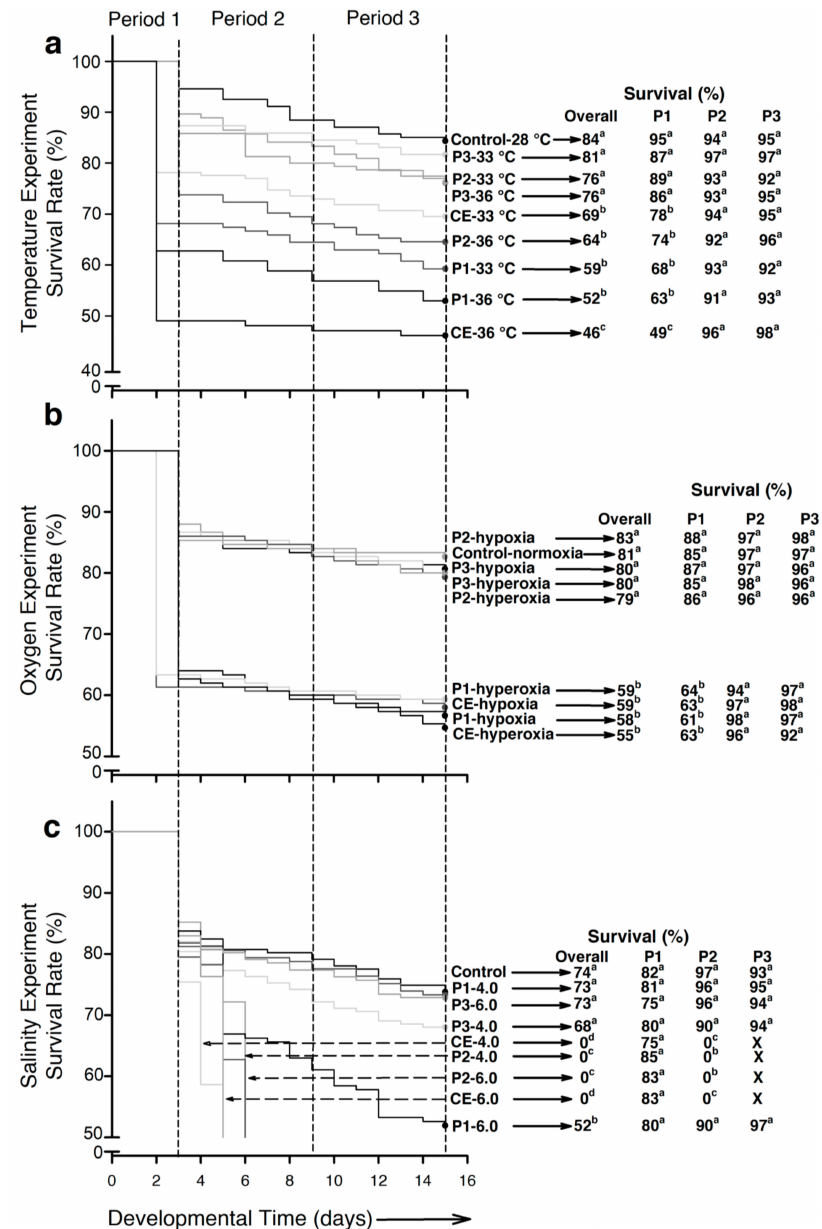
Figure 1. Survival of embryos and larvae of Atractosteus tropicus during each experimental condition. ( a ) Temperature, ( b ) air saturation, ( c ) salinity. Differences in survival between groups for each experiment are represented by lowercase letters ( p < 0.001). Black arrows indicate the corresponding survival percentages for each group. Dashed arrows in ( c ), indicate groups where all larvae died. n = 1350 fertilized eggs (150 per treatment) at the beginning of each